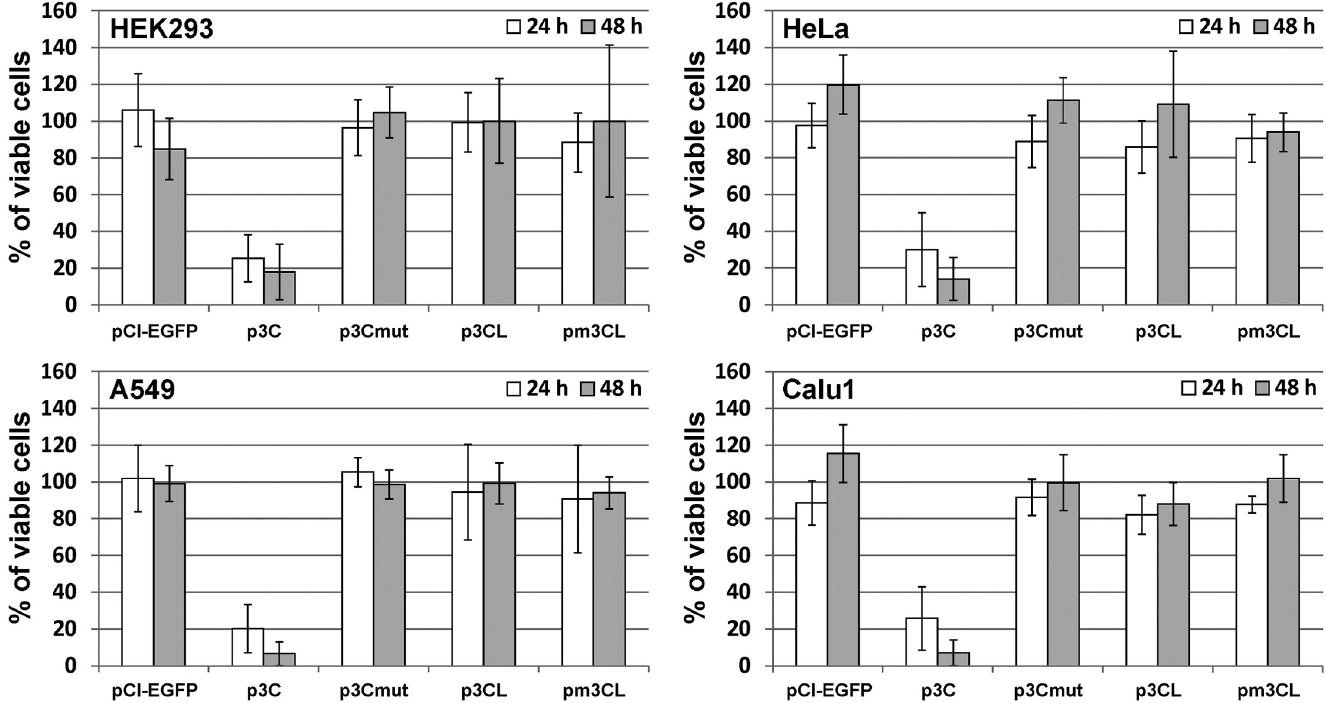
Fig 2. Viability estimation in transfected cultures. HEK293, HeLa, A549 and Calu1 cells were transfected with the indicated plasmids and 24 h and 48 h post transfection metabolic activity was analyzed using CellTiter 96 reagent. Results are expressed as the percentage of viable cells relative to non-transfected cultures. Values are represented as mean ± SD of two independent experiments with triplicates (n =